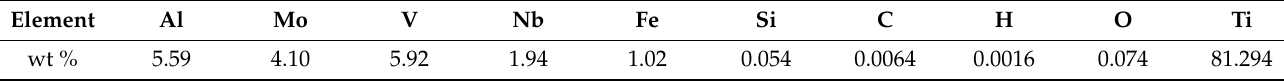
Table 1. Chemical compositions of the titanium alloy TC27.